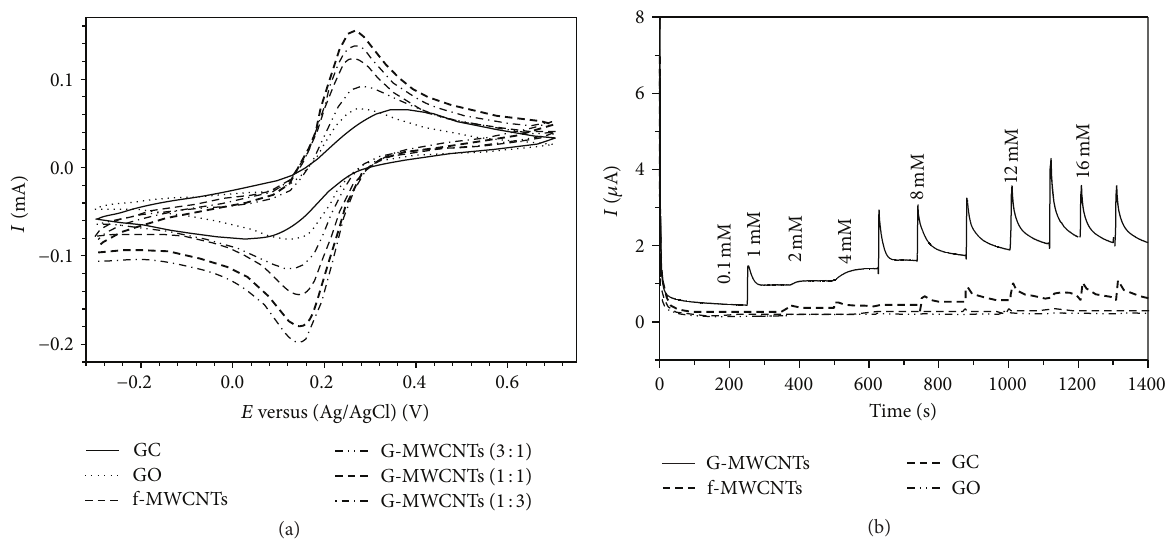
Figure 8: (a) CVs of bare GC electrode and that modified with GO, f-MWCNTs, G-MWCNTs (3: 1), G-MWCNTs (1:1), and G-MWCNTs (1:3). The experiments were carried out in 5.0 mM K 3 [Fe(CN) 6 ] containing 1.0M KCl and the potentials were applied versus Ag/AgCl reference electrode at a scan rate of 100 mVs −1 . (b) Amperometric responses of GC, GO, f-MWCNTs, and G-MWCNTs modified electrodes for successive addition of glucose concentrations (0.1–18mM) at an applied potential of +0.6V, versus Hg/HgO in 0.1M